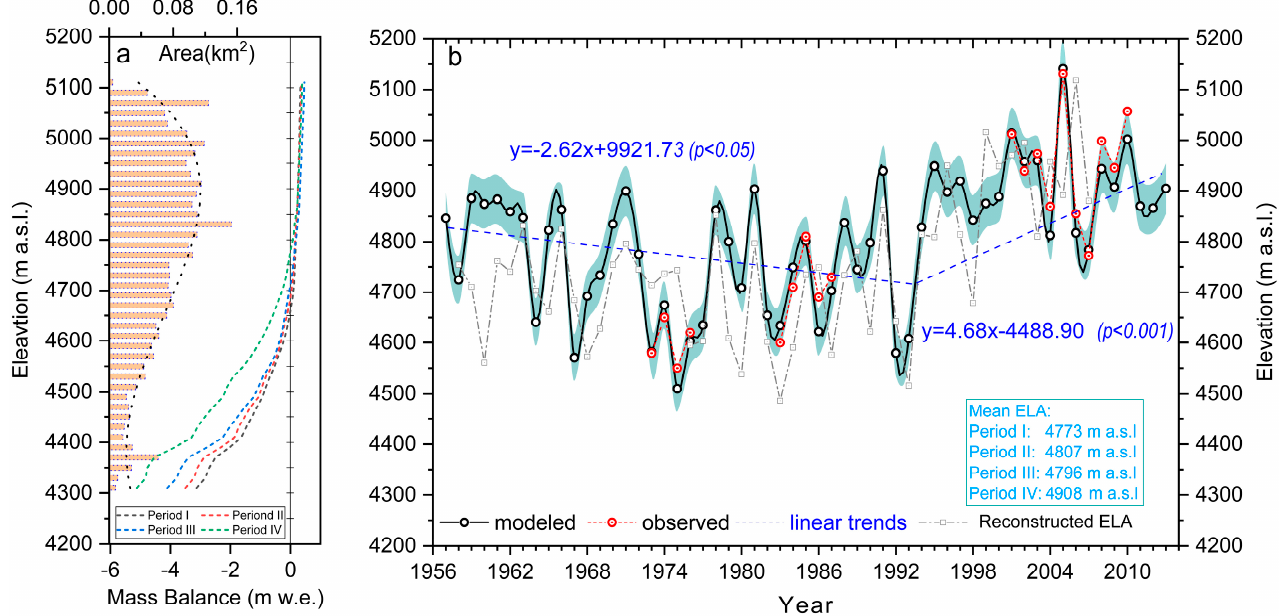
Figure 9. The altitudinal distribution of SMB and mean area were calculated for Qiyi glacier ( a ) and the ELA variation from 1957–2013 ( b ). The reconstructed ELA provided by Wang et al. [13]. The dashed blue line indicates the linear rate of ELA, and the sky-blue shading refers to the 1 δ standard deviation of modeled ELA.